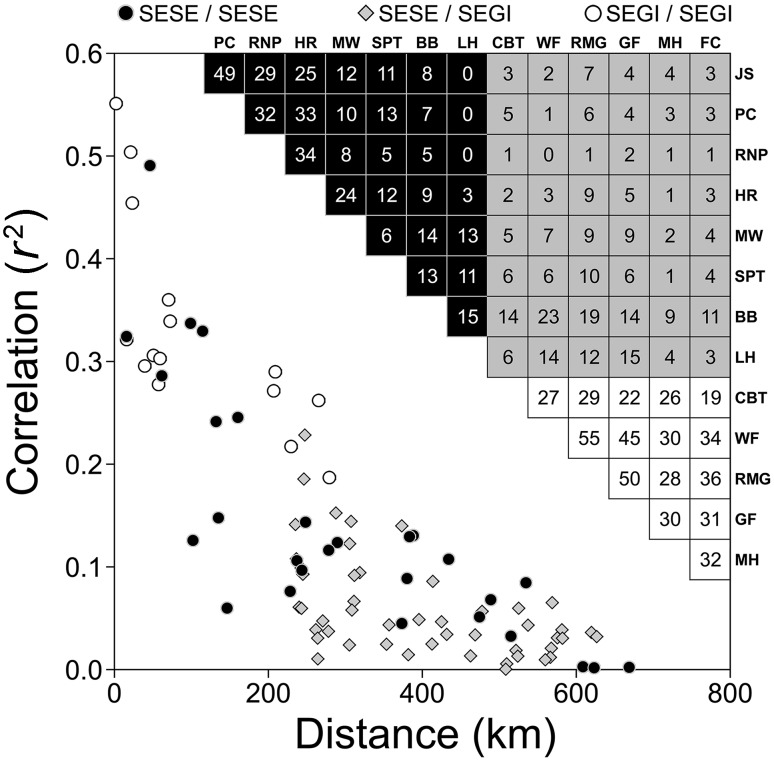
Correlations among redwood tree-ring chronologies and relationships with Euclidean distances between locations.Values in cells are % variance explained (100×r
2) for pairwise correlations over a 259-year common period (1750–2008). Locations arranged by latitude from north (left and top) to south (right and bottom) within species.